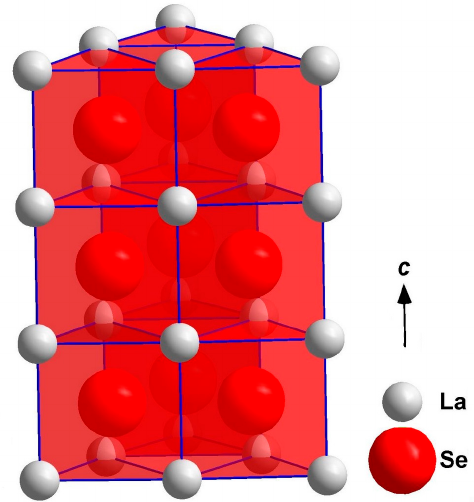
Figure 5. Connected trigonal prisms of La 3 + cations surrounding the Se 2 − anions in B-La 2 OF 2 Se, which build a triple chain along the c- axis.